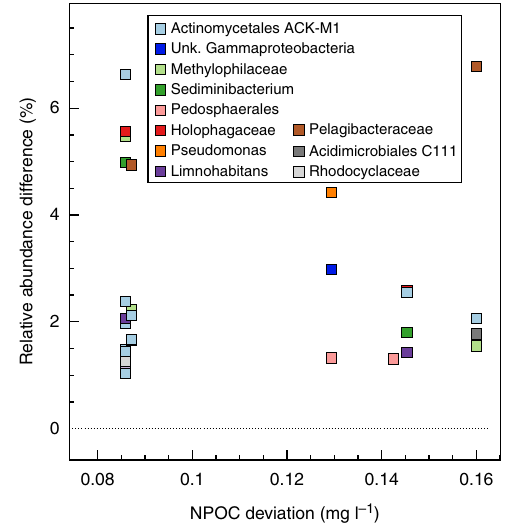
Figure 7 | Microbial groups exhibiting increased relative abundance in samples with greater NPOC deviation from the mixing model. Relative abundance comparisons were made between samples with similar mixing